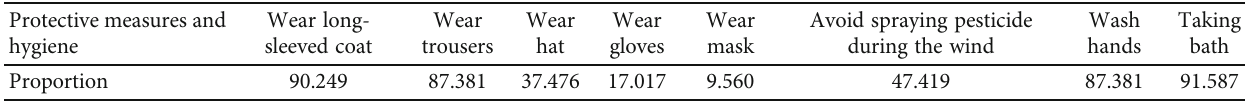
Table 1: Personal protective measures and hygiene.